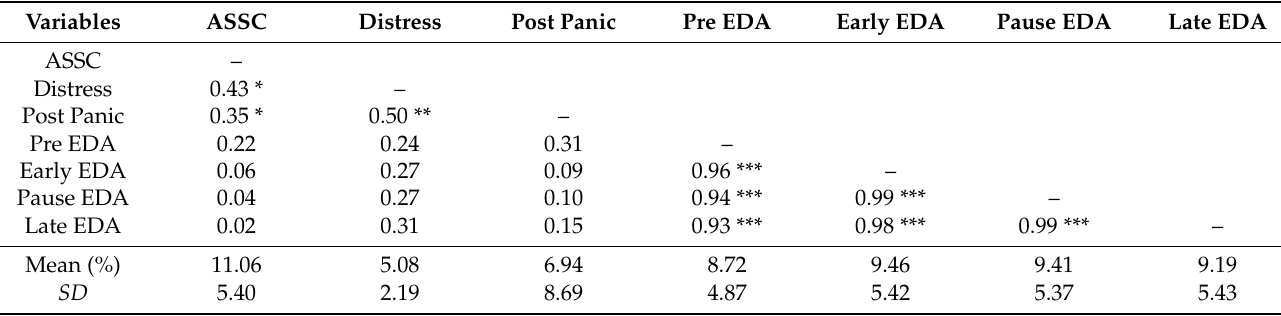
Table 1. Descriptive Statistics and